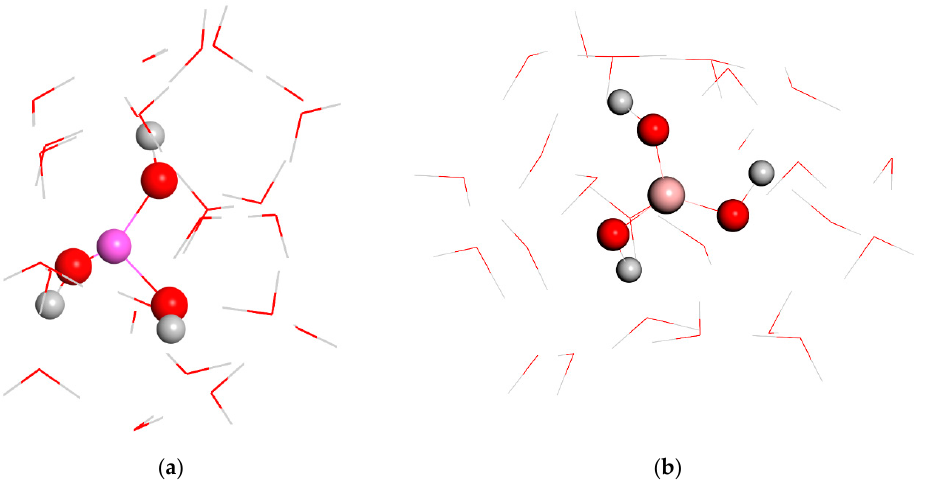
Figure 6. Optimized structures of the hydrated Al(OH) 3 ( a ) and B(OH) 3 ( b ) models. H, O, Al and B atoms are represented in light-gray, red, pink and orange, respectively. Water molecules are represented as sticks.